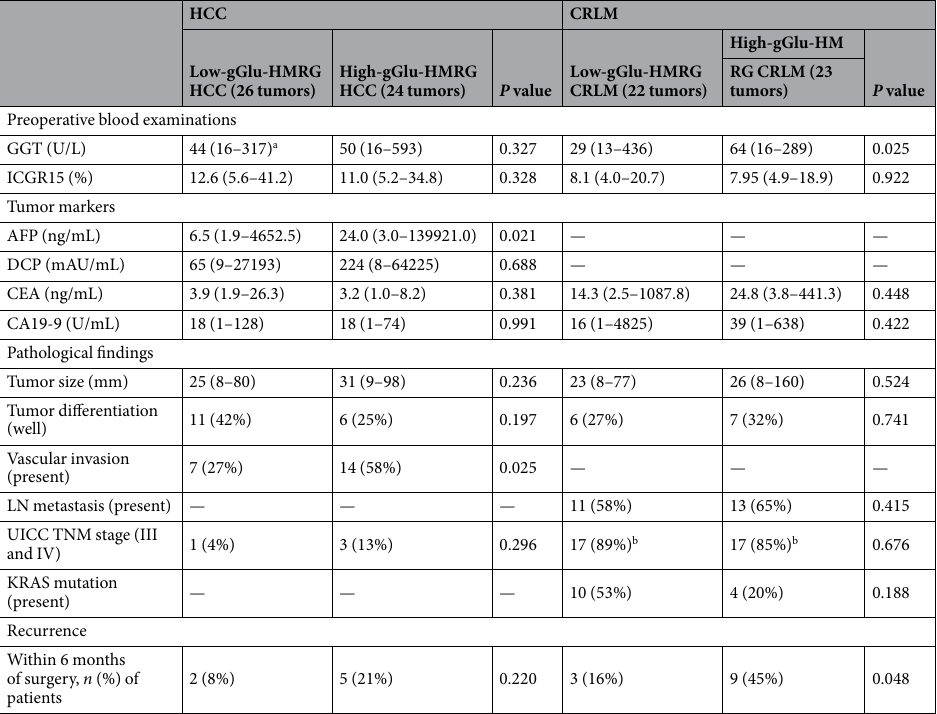
Table 1. Association between gGlu-HMRG fluorescence imaging and tumor-related factors and postoperative outcome. a Data are the median (range) or n (%) of the indicated number of tumors. b UICC 7th edition staging of primary colon cancer. HCC, hepatocellular carcinoma; CRLM, colorectal cancer liver metastasis; GGT, γ -glutamyltranspeptidase; ICGR15, indocyanine green retention test at 15 min; AFP, α -fetoprotein; DCP, des-